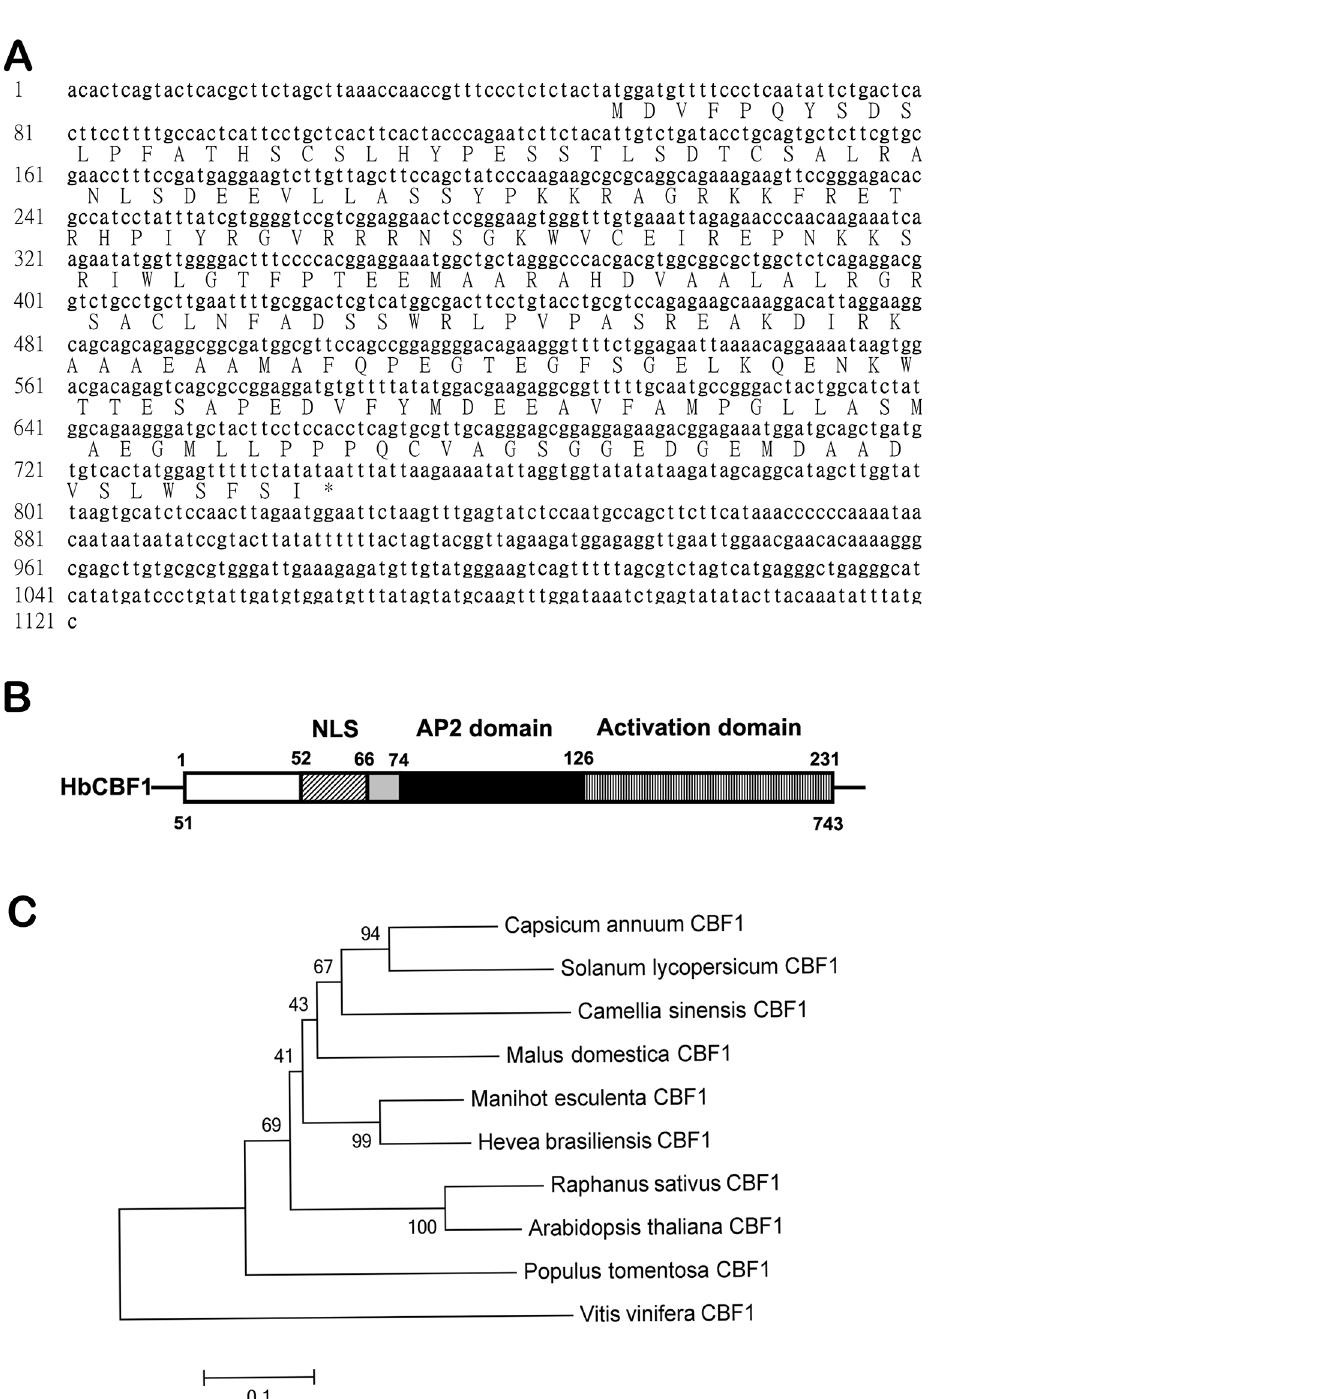
Fig 1. (A) Full length cDNA sequence of rubber tree C-repeat binding factor 1 ( HbCBF1 ) gene and deduced encoding peptides. (B) Conservative domains distribution in HbCBF1 protein. NLS, nuclear localization signal. (C) Phylogenetic tree showing similarity of the deduced Hevea brasiliensis CBF1 protein sequence with those described in other plants. Sequences of each species were downloaded from Genbank by the following accession numbers: Capsicum annuum CBF1, AAZ22480.1; Solanum lycopersicum CBF1, AAS77820.1; Camellia sinensis CBF1, AFN93974.1; Malus domestica CBF1, AAZ20446.1; Manihot esculenta CBF1, AFB83707.1; Raphanus sativus CBF1, ACX48435.1; Arabidopsis thaliana CBF1, AEE85066.1; Populus tomentosa CBF1, ABC79626.1; Vitis vinifera CBF1, AEM37861.1. The phylogenetic tree was constructed using a Mega 6.06 software.